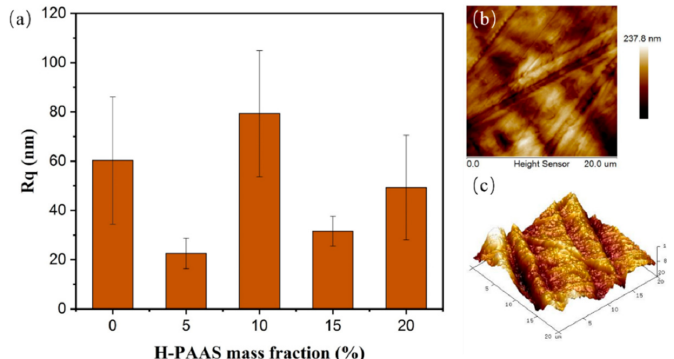
Figure 6. The Rq of specimens with different H-PAAS mass fractions ( a ). 2D image ( b ) and 3D image ( c ) of Specimen 3.